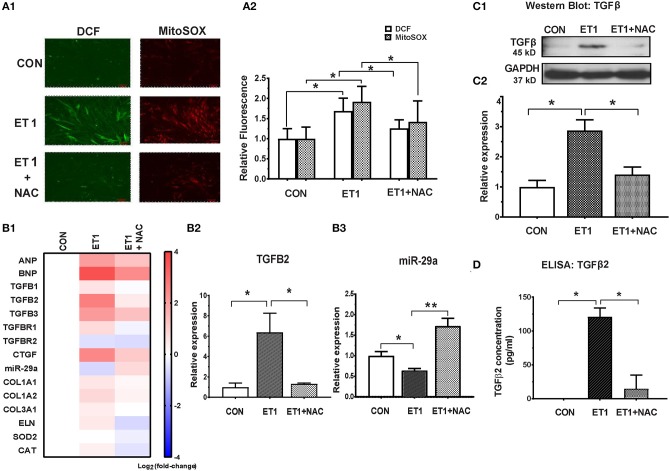
NAC abolished the ET1 stimulated increase in TGFβ expression and miR-29a suppression in neonatal rat cardiac myocyte cultures. (A1) Representative images of cardiac myocytes labeled with DCF and Mitosox, obtained by 2-photon microscopy. ET1 (100 nM) increased H2O2 (DCF fluorescence) and superoxide (MitoSOX fluorescence) in cardiac myocytes, which is prevented by NAC (3.5 mM). (A2) Summary of fluorescence data representing H2O2 (DCF) and superoxide (Mitosox) reveals increase in H2O2 and superoxide following ET1 (100 nM) treatment, which is abrogated by NAC (3.5 mM). DCF and Mitosox fluorescence was calculated from 10 randomly selected regions from three experiments (~300 cardiac myocytes). (B1) Heat map summarizing expression of miR-29a, select pro-fibrotic and redox genes in cardiac myocytes, following treatment with ET1 (100 nM) and ET1 + NAC (3.5 mM). ET1 suppressed miR-29a expression and increased expression of TGFB1-3, CTGF, and collagen genes. NAC increased miR-29a and blunted expression of pro-fibrotic genes following ET1 treatment. Differentially expressed genes are shown in graduated red (up-regulated) or blue (down-regulated) according to their log2 fold change compared to control (untreated cells). (B2)
TGFB2 was the most up-regulated TGFB gene in cardiac myocytes following ET1. TGFB2 gene expression increased 6-fold following ET1 (100 nM) treatment. NAC antagonized the effect of ET1 and reduced TGFB2 expression back to baseline levels in cardiac myocytes (linear fold change is presented). (B3) ET1 suppressed miR-29a expression, and NAC + ET1 increased miR-29a expression in cardiac myocytes (linear fold change is presented). (C1) Representative western blot image for TGFβ expression in cardiac myocytes (from one experiment) demonstrates that ET1 increases TGFβ, which is antagonized by NAC. (C2) Bar graph summarizing band intensity data from three experiments (biological replicates) following treatment with ET1 (100 nM) and ET1 + NAC (3.5 mM) shows that ET1 increases TGFβ protein expression in cardiac myocytes, which is blunted by NAC (data are expressed as mean ± S.D.; n = 3; one-way ANOVA and Tukey's test were used to compare ET1, ET1 + NAC, and control; *P < 0.05). (D) TGFβ2 secretion by cardiac myocytes was measured by ELISA. ET1 (100 nM) stimulated TGFβ2 secretion by cardiac myocytes, which was abrogated by NAC (3.5 mM). [(A1,A2,B1–B3,D) Data are expressed as mean ± S.D.; n = 3 for each condition; all experiments were repeated three times. One-way ANOVA and Tukey's test were used to compare ET1, ET1 + NAC, and control; **P < 0.01, *P < 0.05].